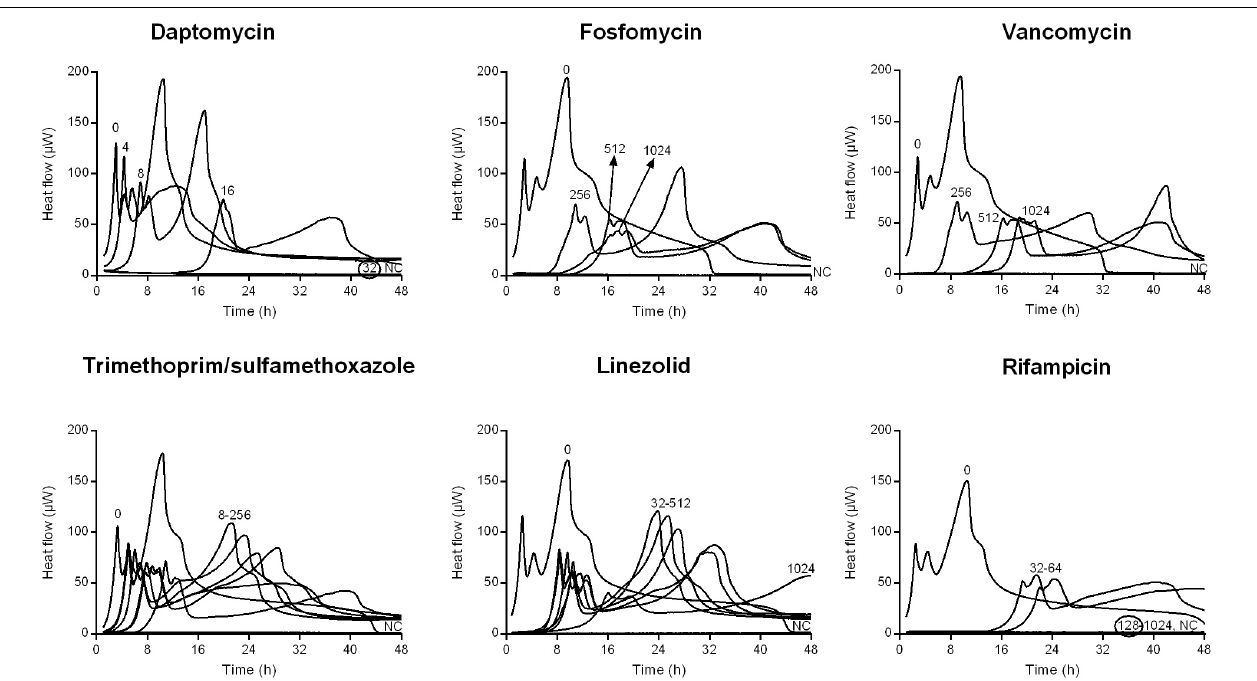
FIGURE 1 | Isothermal microcalorimetry evaluation of antimicrobial activity of daptomycin, fosfomycin, vancomycin, trimethoprim/sulfamethoxazole, linezolid, and rifampicin against biofilm MRSA. Numbers represent antibiotic concentrations ( µ g/ml). A negative control has been used to confirm medium sterility (NC). Trimethoprim/sulfamethoxazole concentrations are expressed as the trimethoprim concentrations. Circled values represent the MBBC. Representative data of replicated experiments are